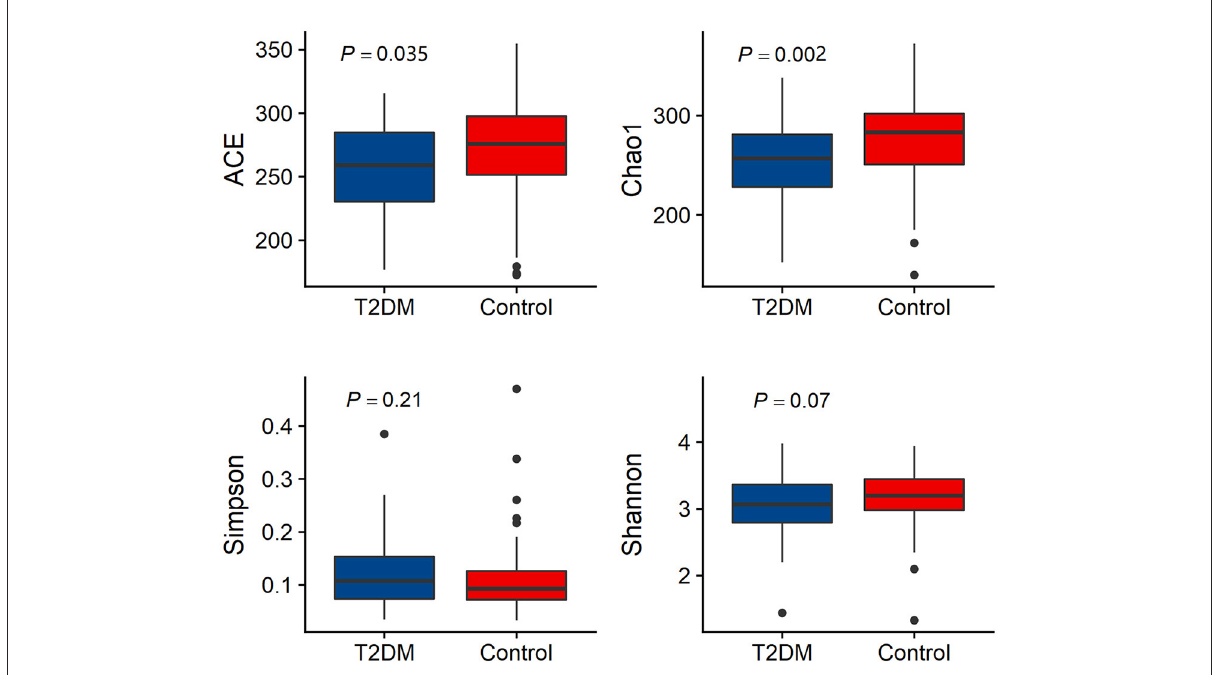
FIGURE1 Comparison of alpha diversity (Ace index, Chao1 index, Simpson index and Shannon index) between the gut microbiota of T2DM and controls.